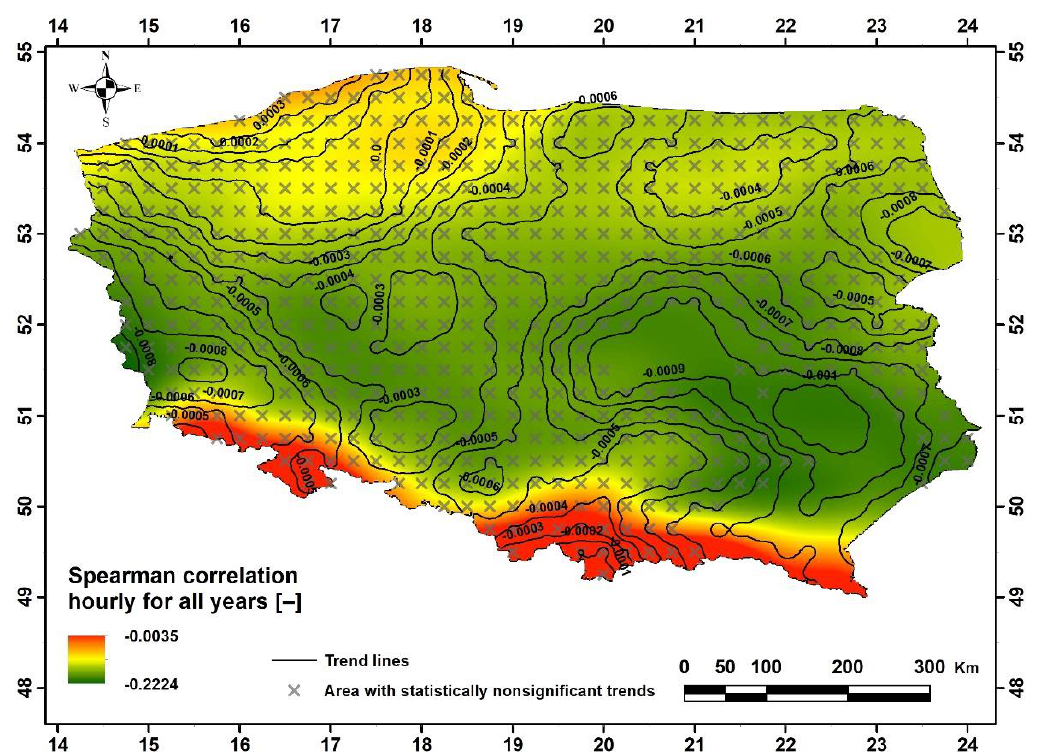
Figure 8. Complementarity between solar and wind resources based on hourly resources availability, 1980–2019. Crosses show where trends (isolines) are not statistically significant.